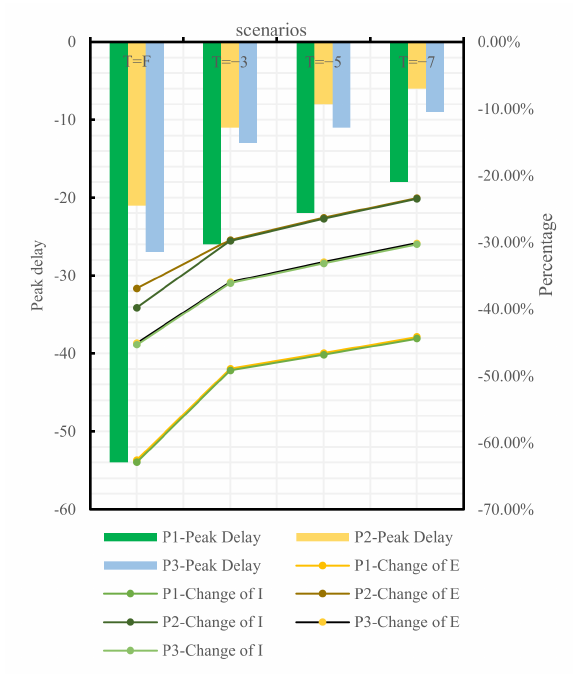
Figure 13. Comparison between T = F, − 3, − 5, − 7 of different policies and no traffic control